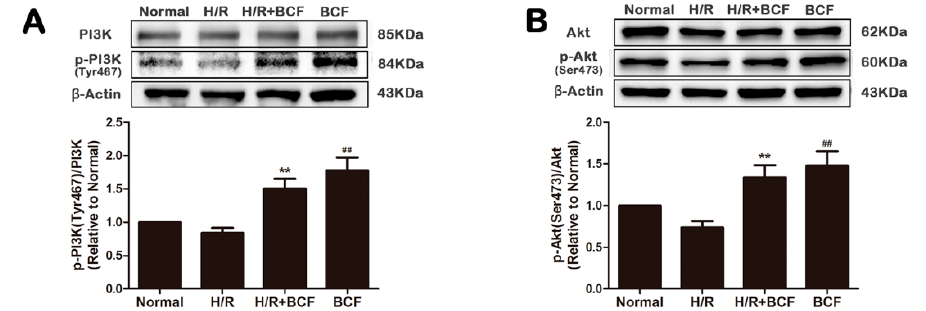
Figure 2. Effect of BCF on PI3K/Akt signaling pathway. Pretreatment with BCF (3.125 μ g/mL) for 4 h prior to H/R, the protein expression of PI3K ( A ), p-PI3K (Tyr467) ( A ), Akt ( B ), and p-Akt (Ser473) ( B ) was measured by western blotting. Quantitative analysis of the ratio of p-PI3K (Tyr467) to PI3K and p-Akt (Ser473) to Akt in protein expression were evaluated. Values were represented as mean ± SD ( n = 6, each group). ** p < 0.01 vs. H/R group. ## p < 0.01 vs. normal group.